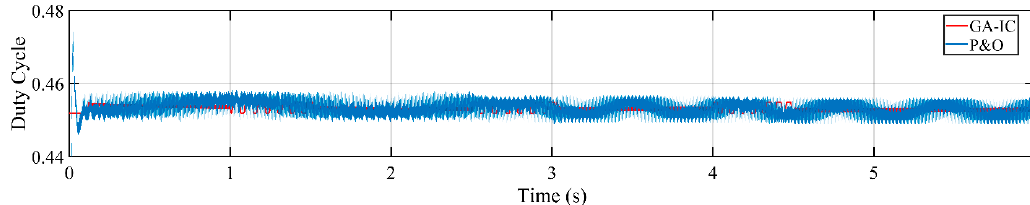
Figure 22. Case 2 duty cycle comparison of modified GA-IC vs. P&O.